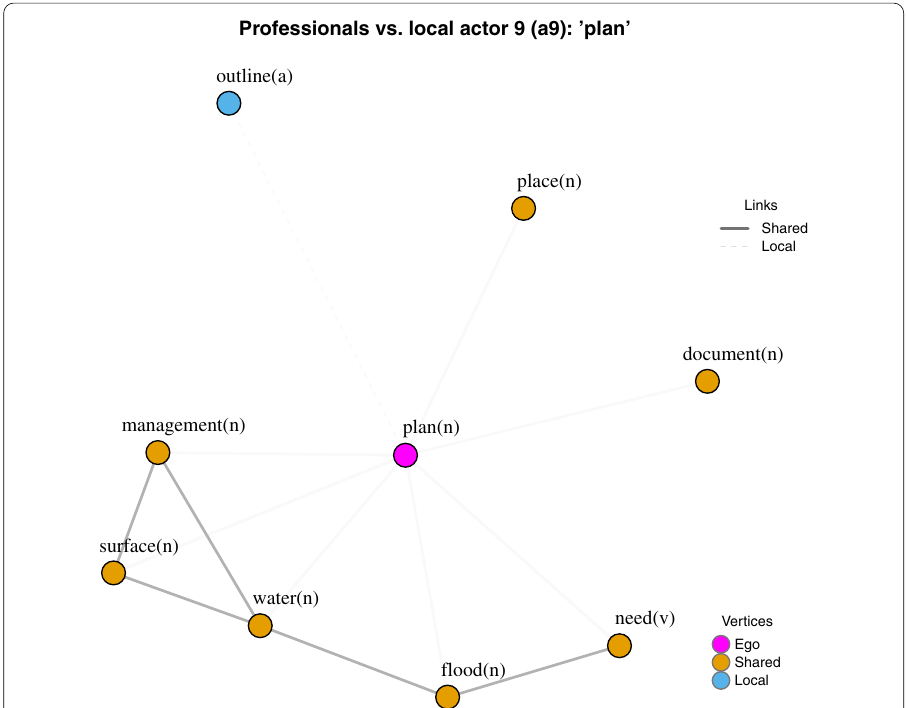
Fig. 6 Professionals versus local actor a9: “plan”. For display purposes, only shared and local-specific concepts are shown. The professional network contains 480 other concepts linked with